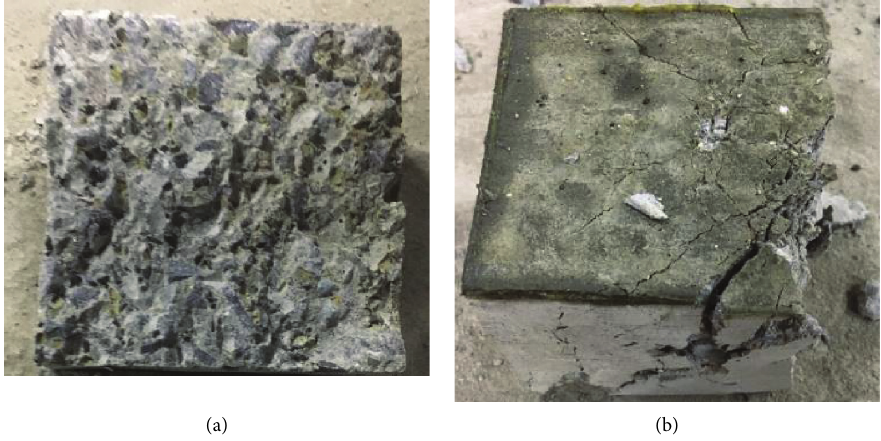
Figure 14: 10% rubber concrete with 0 freeze-thaw cycles. (a) Specimen section. (b) Static compressive failure